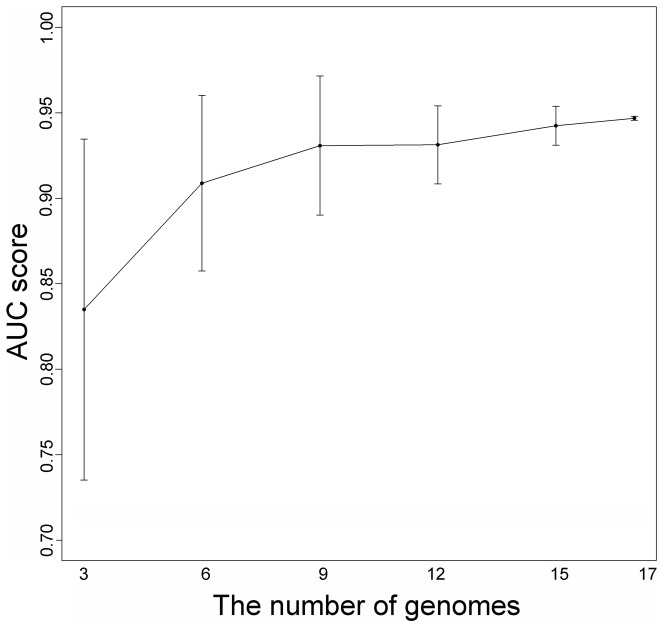
AUC scores of jackknife test.We randomly picked 10 times of 3, 6, 9, 12, 15, 17 genomes from the remaining 18 genomes and computed the AUC scores of predicting Ecol. Error bars are representing 90% confidence intervals on the estimates of the means.